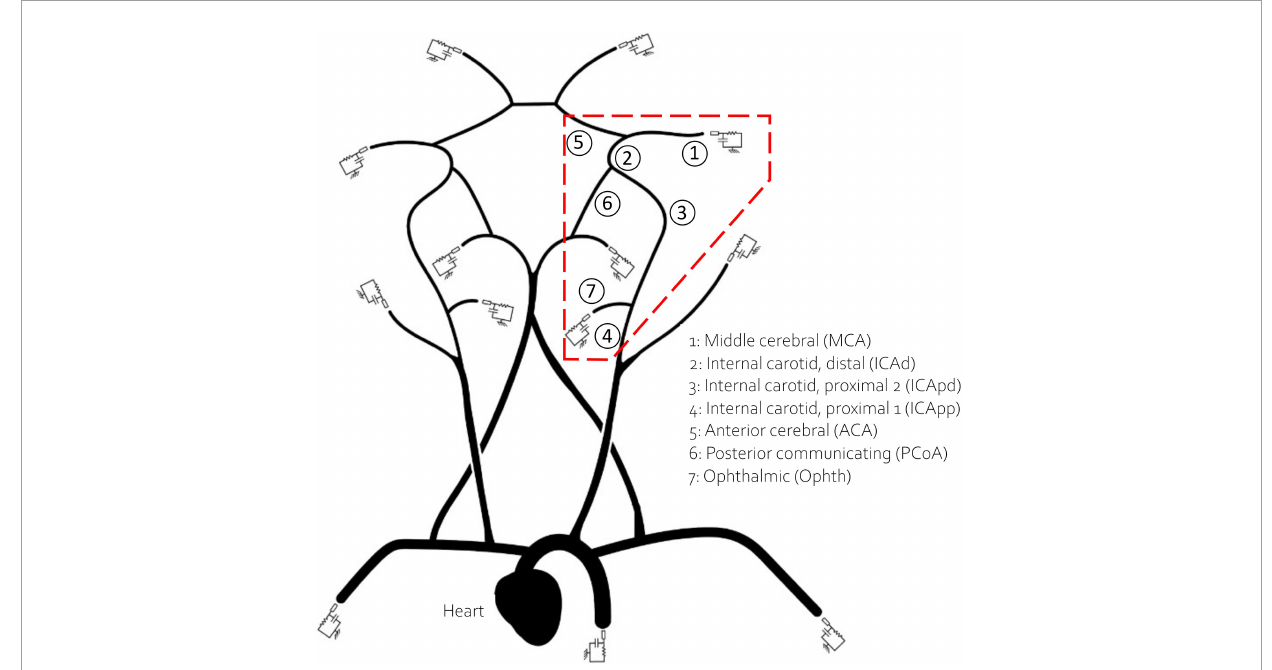
FIGURE1 The network used in this study. The inlet boundary condition is applied at the heart. The 13 outlet vessels are coupled to three element windkessel models. Vessels in the red dashed polygon, which encircles the retrieval path, are numbered and named for reference.